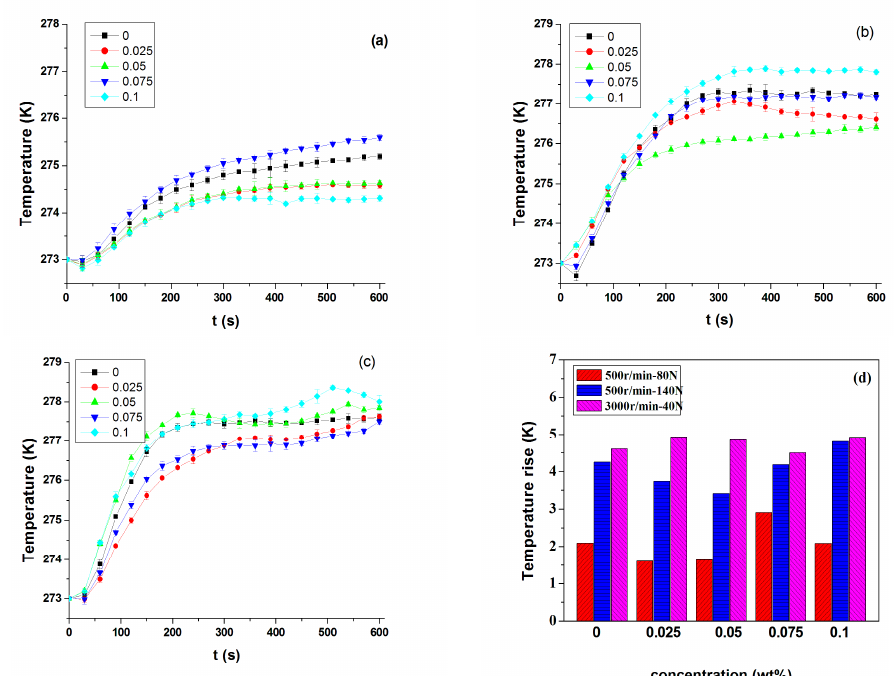
Figure 5. Temperature rise for Si 3 N 4 /Si 3 N 4 sliding pairs under different conditions. ( a ) 80 N load and 500 r·min − 1 rotational speed, ( b ) 140 N load and 500 r·min − 1 rotational speed, ( c ) 40 N load and 3000 r·min − 1 rotational speed, and ( d ) comparison of temperature rise results of the above.